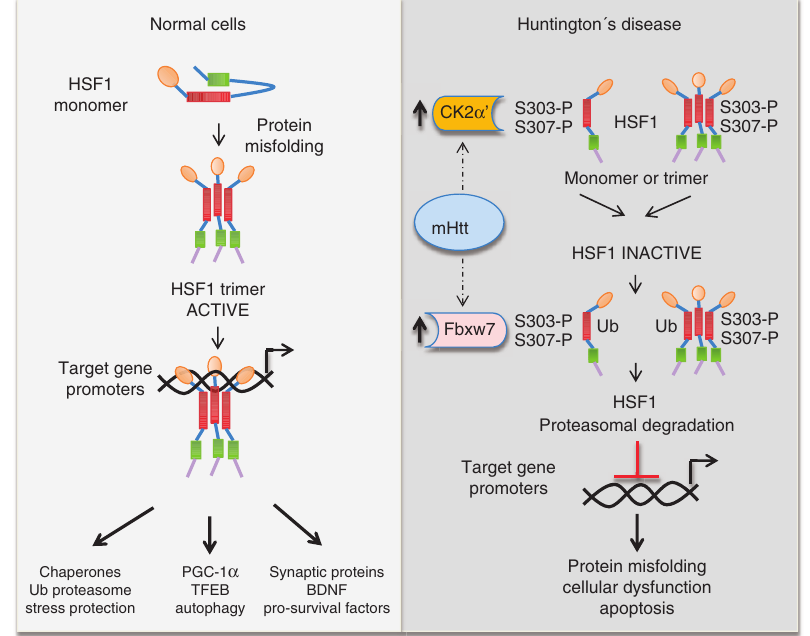
Figure 9 | Model for HSF1 degradation in Huntington’s Disease. mHtt expression increases the abundance sof CK2 a 0 kinase and the Fbxw7 Fbox protein. CK2 a 0 phosphorylates HSF1 S303 and S307, inactivating HSF1 transcriptional activity and recruiting the Fbxw7 E3 ligase. The E3 ligase